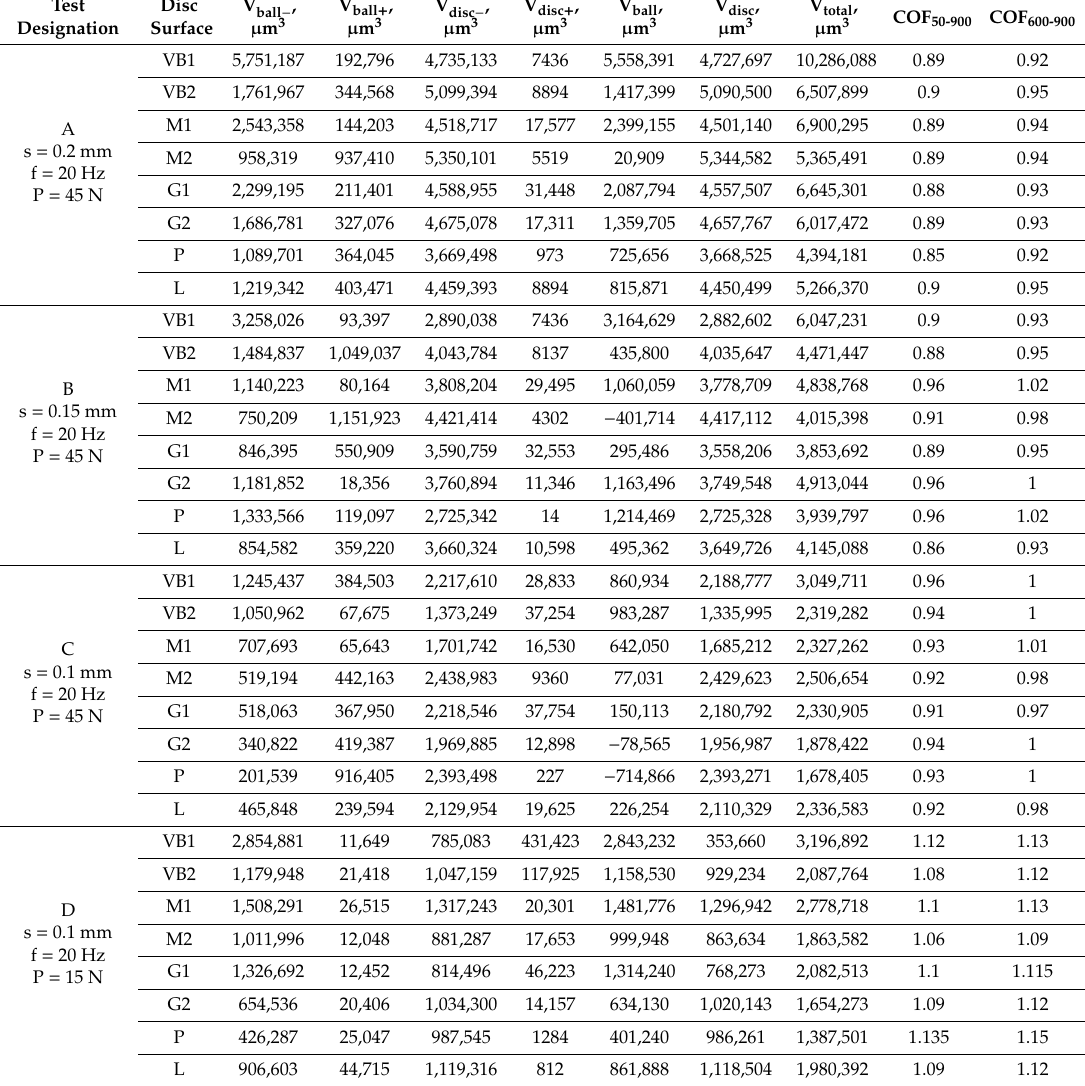
Table 3. Results of tribological tests; V disc —volumetric wear of disc, V ball —volumetric wear of ball, COF—friction coe ffi